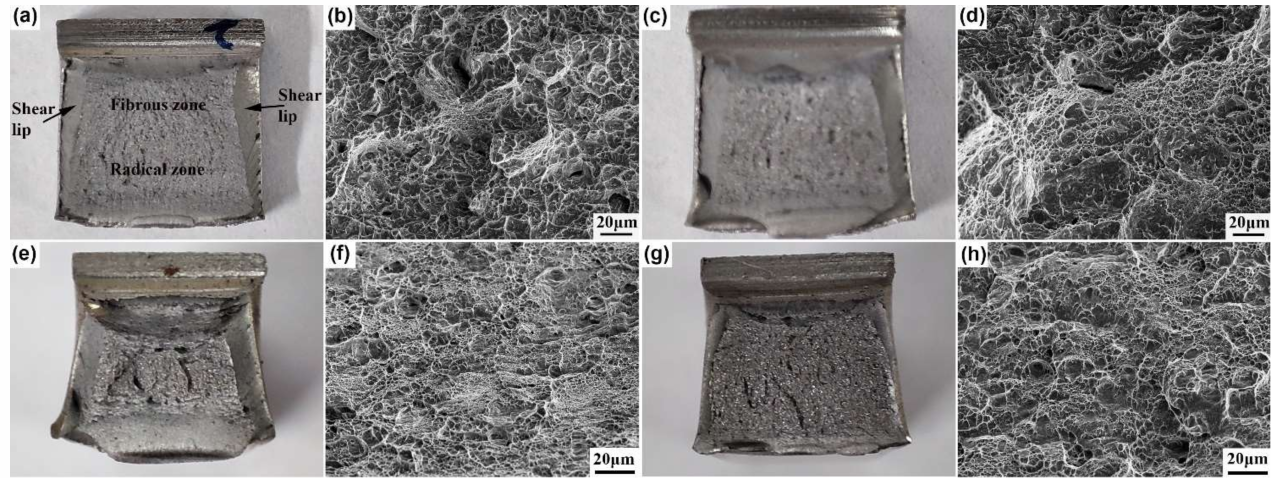
Figure 10. Fractographs of impacted specimens of both steels at different heat treatment processes. ( a , b ): 0.33C—280 ◦ C; ( c , d ): 0.33C—320 ◦ C; ( e , f ): 0.21C—340 ◦ C; ( g , h ): 0.21C—380 ◦